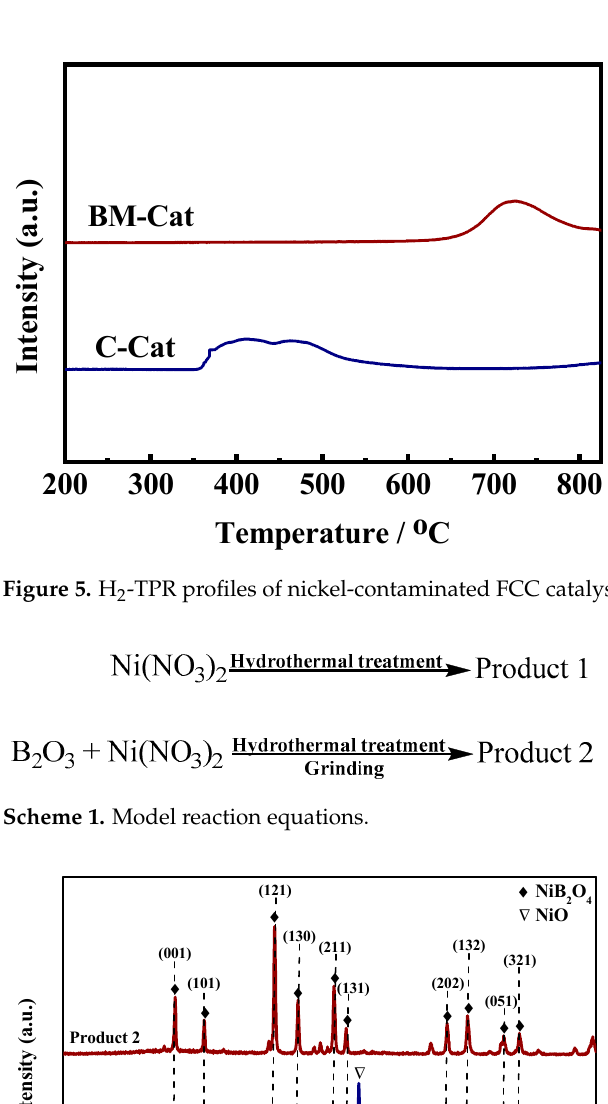
Scheme 1. Model reaction equations.